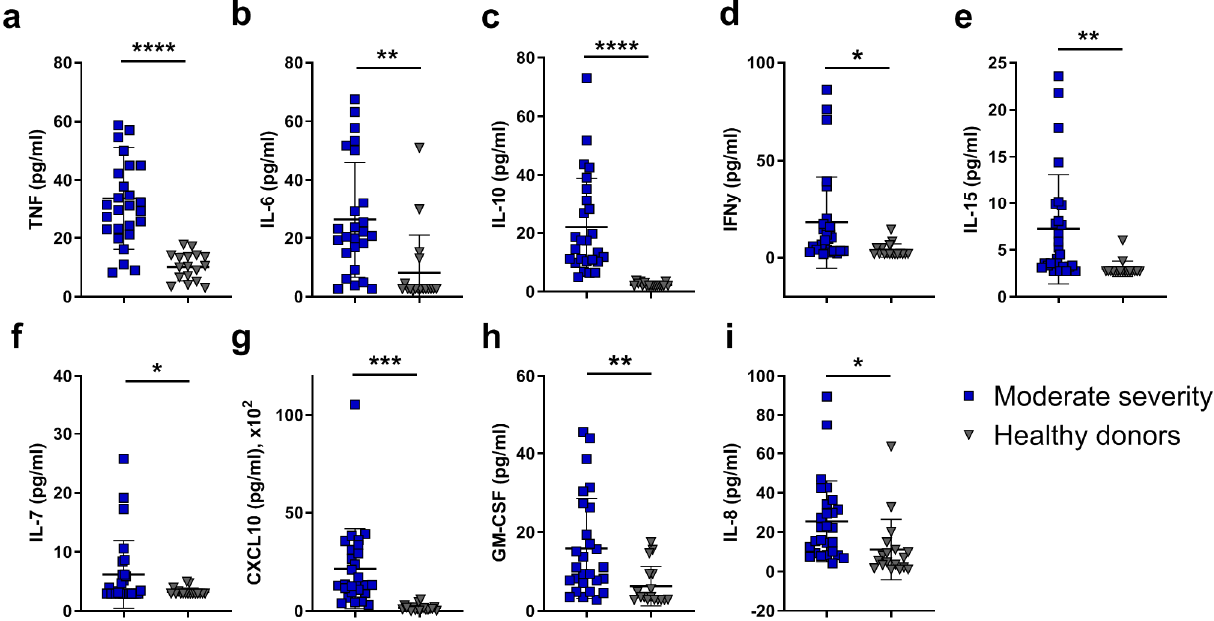
Figure 3. Systemic production of cytokines and chemokines in the blood of patients with moderate-severity disease indicates the activation of a broad immune response. Concentration of ( a ) TNF, ( b ) IL-6, ( c ) IL-10, ( d ) IFN γ , ( e ) IL-15, ( f ) IL-7, ( g ) CXCL10, ( h ) GM-CSF, ( i ) IL-8 in pg/mL in the serum of healthy donors and moderate-severity patients. Data are presented as individual values with mean ( ± SD). * p < 0.05, ** p < 0.01, *** p < 0.001, **** p < 0.0001.